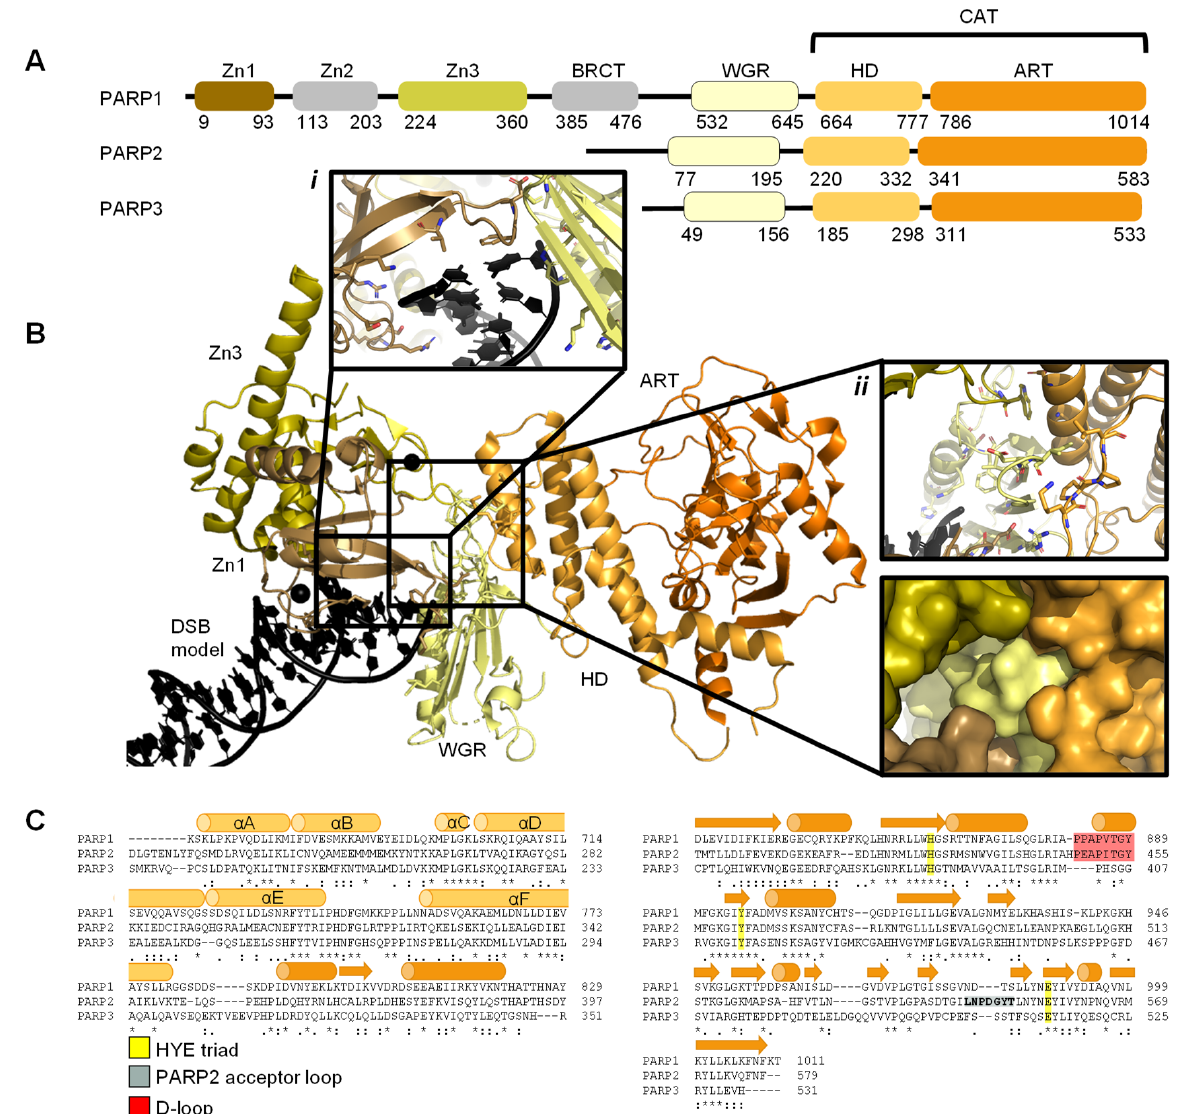
Figure 1 . Overview of PARP1, PARP2, and PARP3 . ( A ) . Schematic overview of the domains of PARP1, PARP2, and PARP3, with amino acid numbers indicating domain boundaries corresponding to Uniprot entries P09874, Q9UGN5, and Q9Y6F1; ( B ) . Crystal structure of PARP1 bound to a double-strand DNA molecule representing one end of a double-strand break (DSB) (Protein Data Bank (PDB) entry 4DQY [34]). Domain colours correspond to A. Inset i : interactions of Zn1 and WGR with a DSB model. Inset ii : interdomain interactions between Zn1, Zn3, WGR, and HD shown as cartoons (top) and surface representations (bottom). All figures in this review containing protein structures were generated in PyMOL [43]; ( C ) . Structure-based sequence alignment of CAT domains of PARP1, PARP2, and PARP3 was generated in PyMOL [43]. Sequence alignment was generated in Clustal Omega [44] provided by EMBL-EBI [45]. Secondary structure is represented by cylinders as α -helices and arrows as β -sheets, respectively. Sequence conservation is shown, where an asterisk represents fully conserved, a colon represents strongly similar properties and a period represents weakly similar properties. The conserved histidine, tyrosine, glutamic acid (HYE) triad is shown in yellow, the PARP2 acceptor loop in grey, and the D-loop in red.